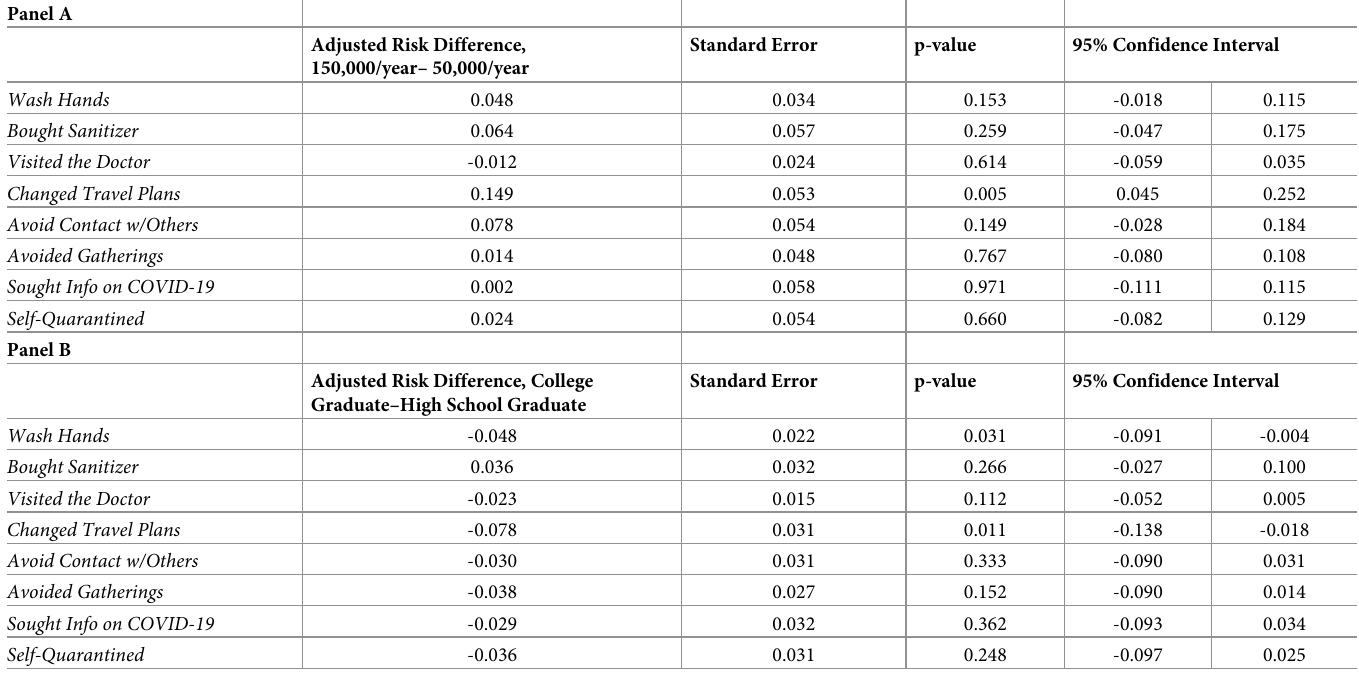
Table 3. Adjusted risk differences for income and education. This table reports the adjusted risk differences for eight health behaviors. These are the differences between Americans earning $150,000 per year and those earning $50,000 per year, from the statistical models in Fig 1 (S3 Table in S1 File), adjusting for all other